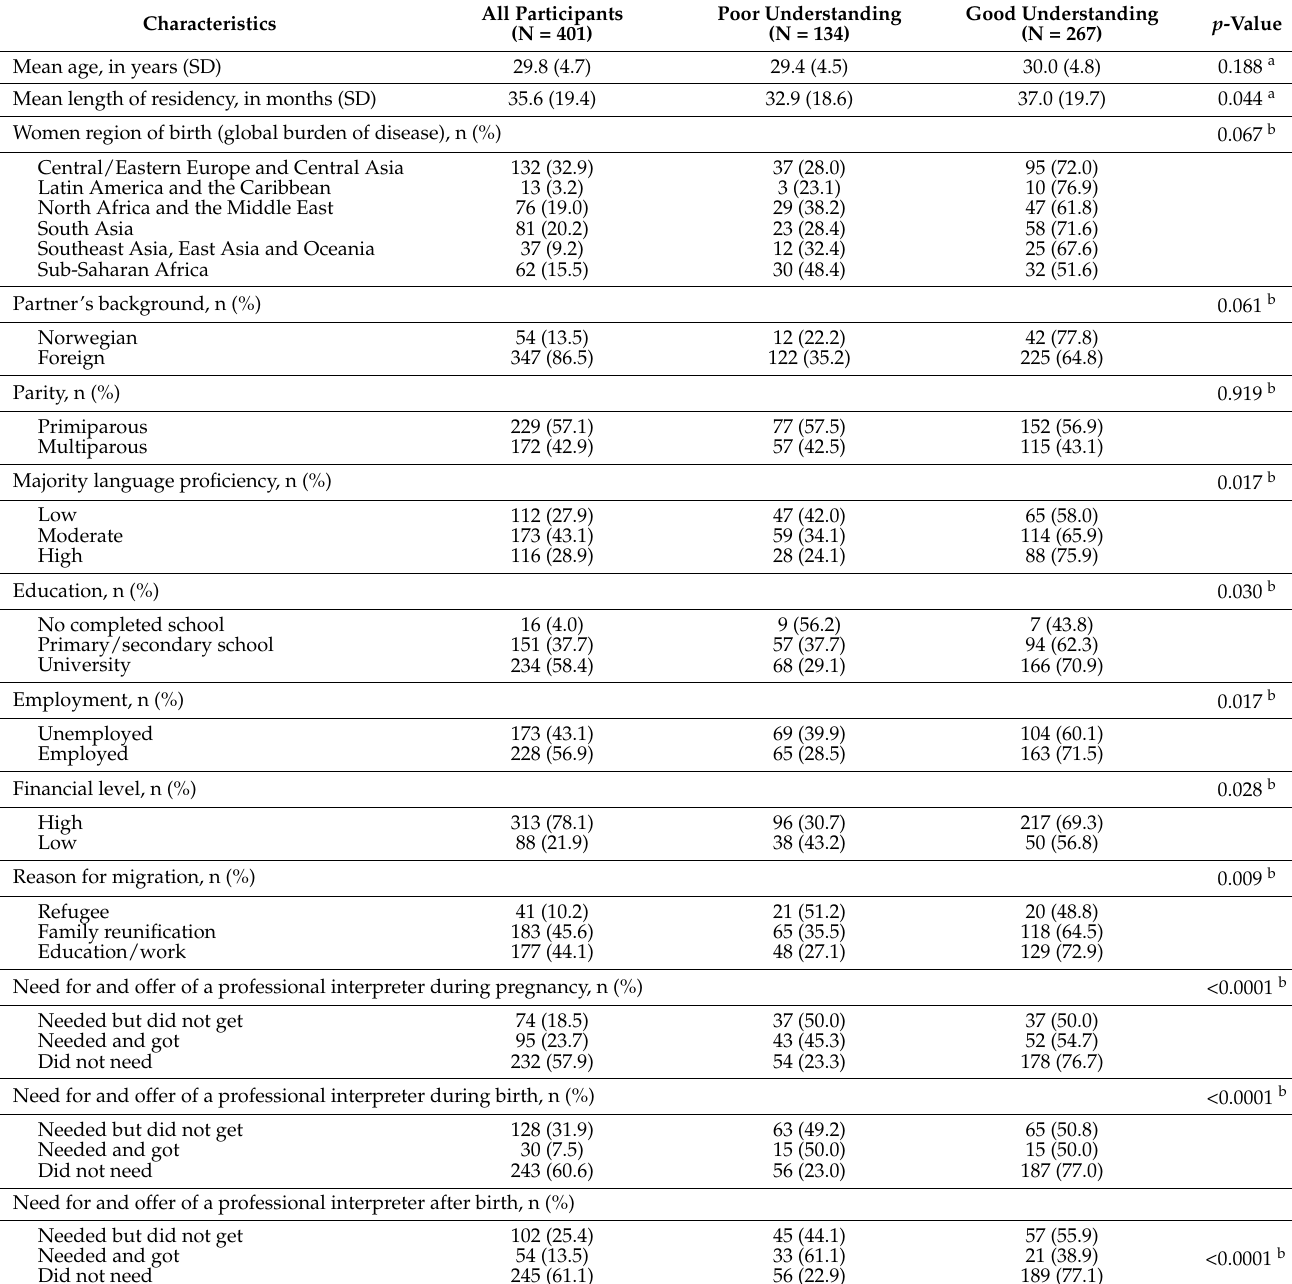
Table 1. Characteristics of all study participants and according to poor or good understanding of information provided by maternity staff, n (%) or mean